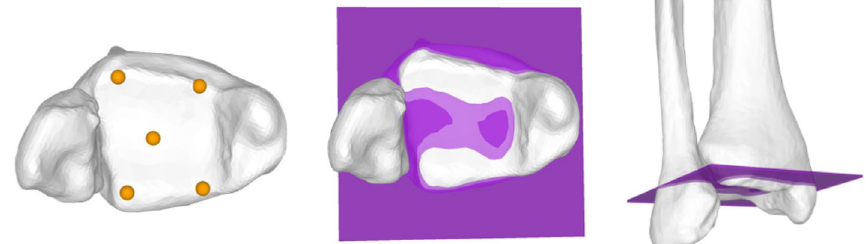
Fig. 2 Definition of the ankle joint line. The average of five standardized surface landmark points (two at the anterior ridge, two at the posterior ridge, one centered at tibial plafond) define the ankle joint